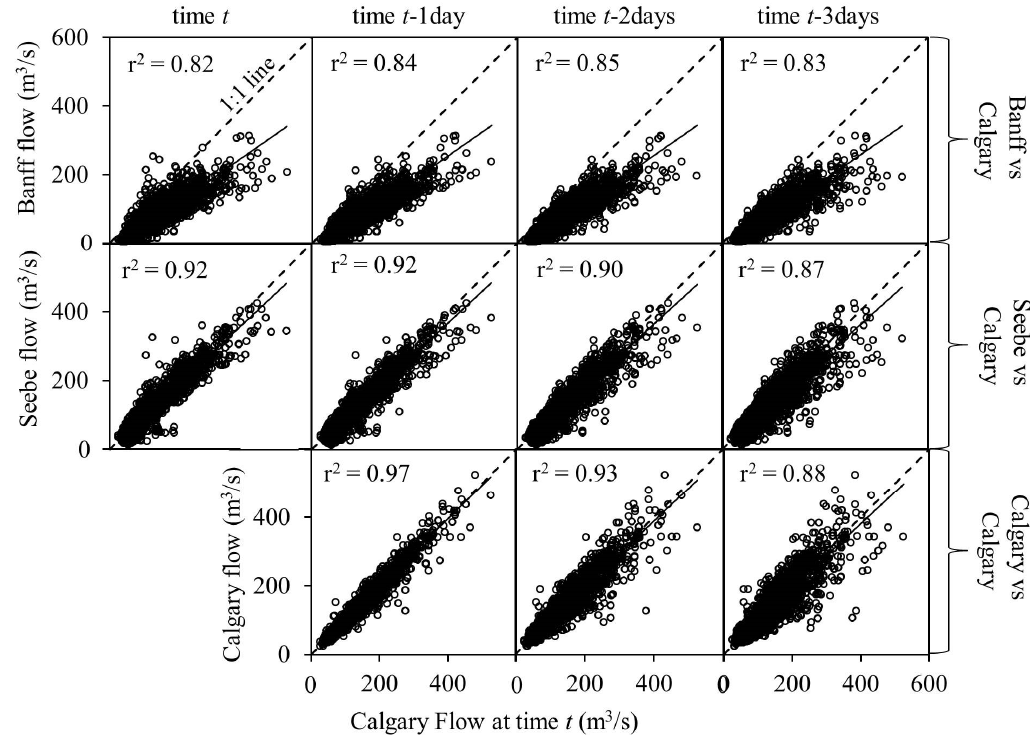
Figure 3. Determination of lead time determination for forecasting flow at Calgary using the measured flows from Banff, Seebe, and Calgary stations during the time t , t -1 day, t -2 days, t -3